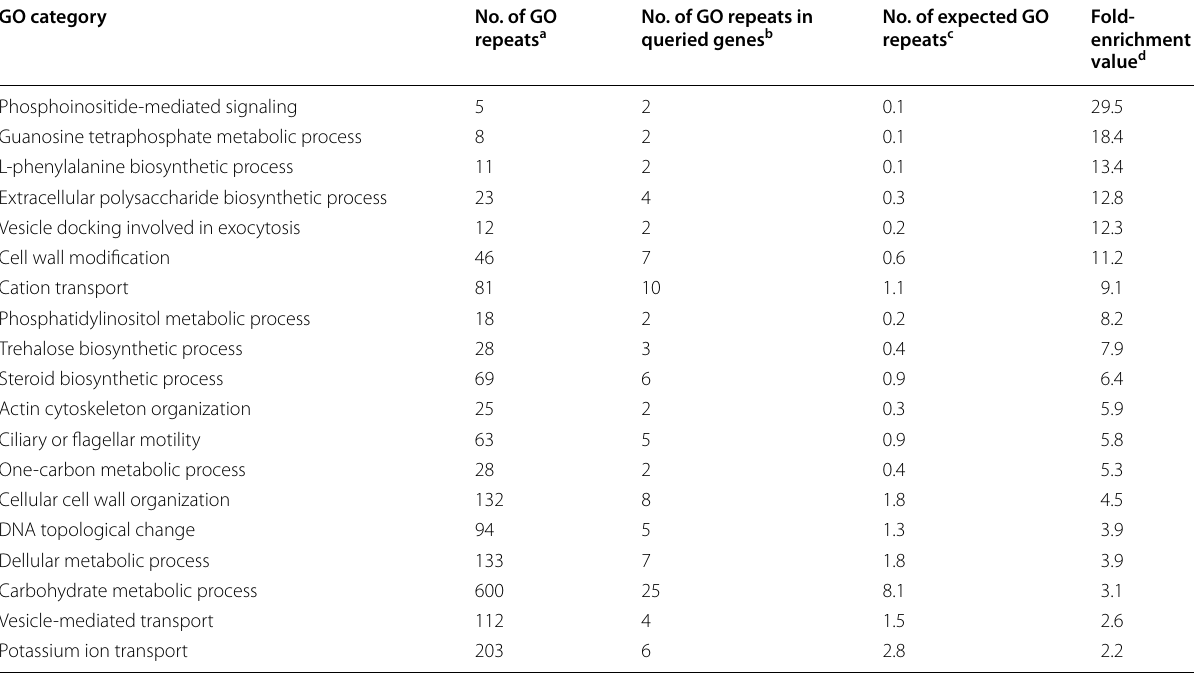
Table 2 The analysis of significantly enriched Gene Ontology terms for downregulated genes in ossndp3 anthers compared to wild type anther during maturation